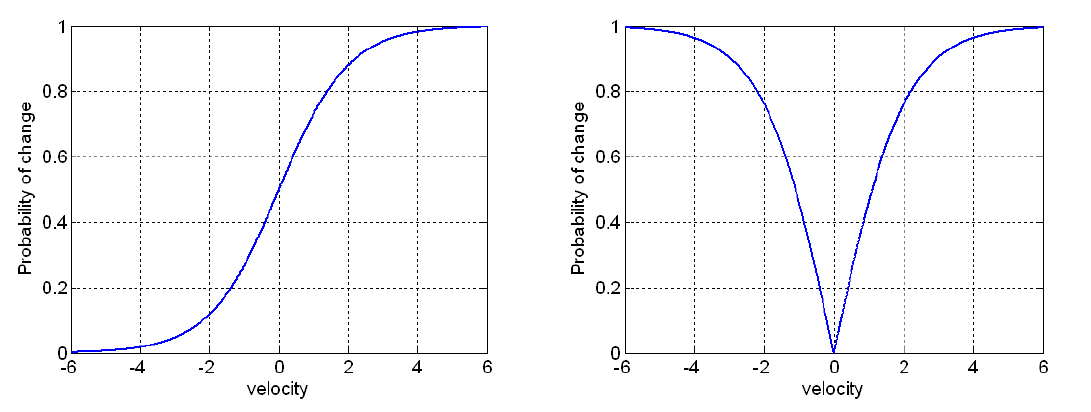
(a) Sigmoid function for binary PSO (b) Scaling function for integer